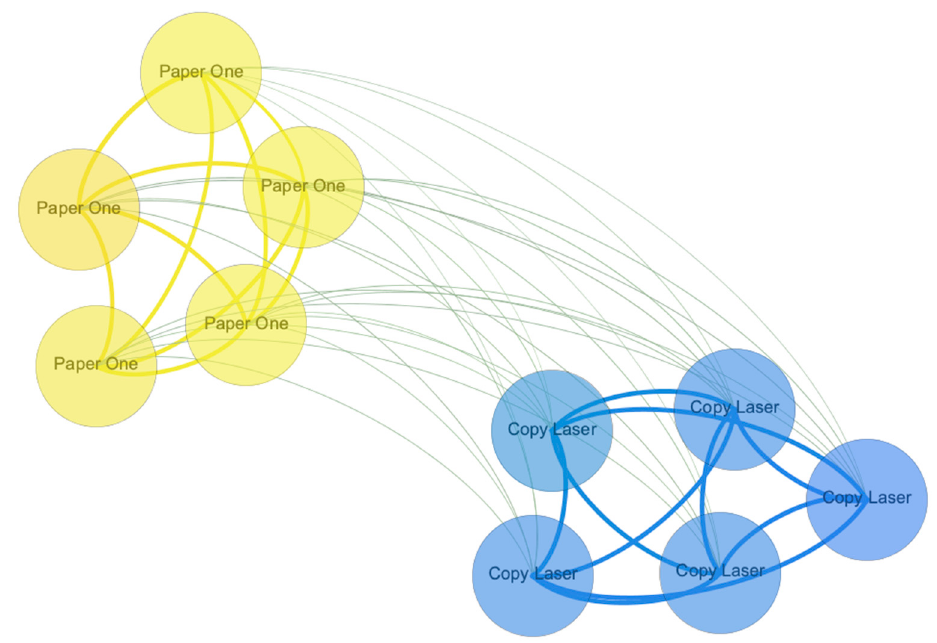
Figure 6. Test 2, distinguishing between two different paper types; Copy Laser and Paper One using the algorithm proposed in [35].